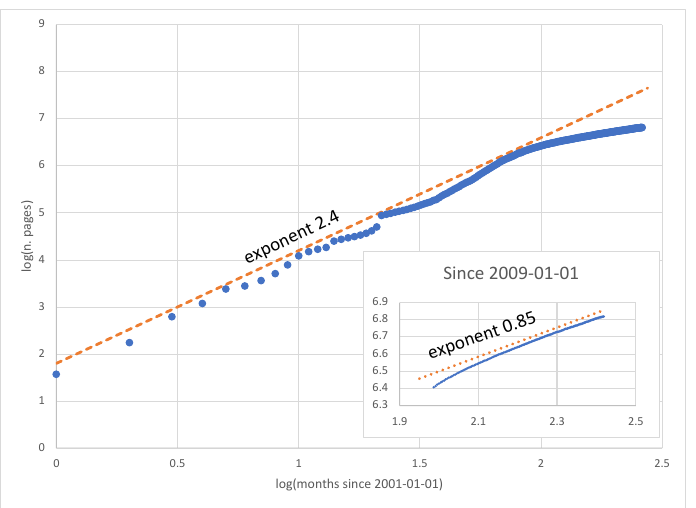
Figure 10. Log–log plot of the number of Wikipedia pages from 1 January 2001 (recorded each month). The initial growth can be approximated by a power law with an exponent of about 2.4, but there is a marked change in growth around 1 January 2009, with an exponent of about 0.8 and